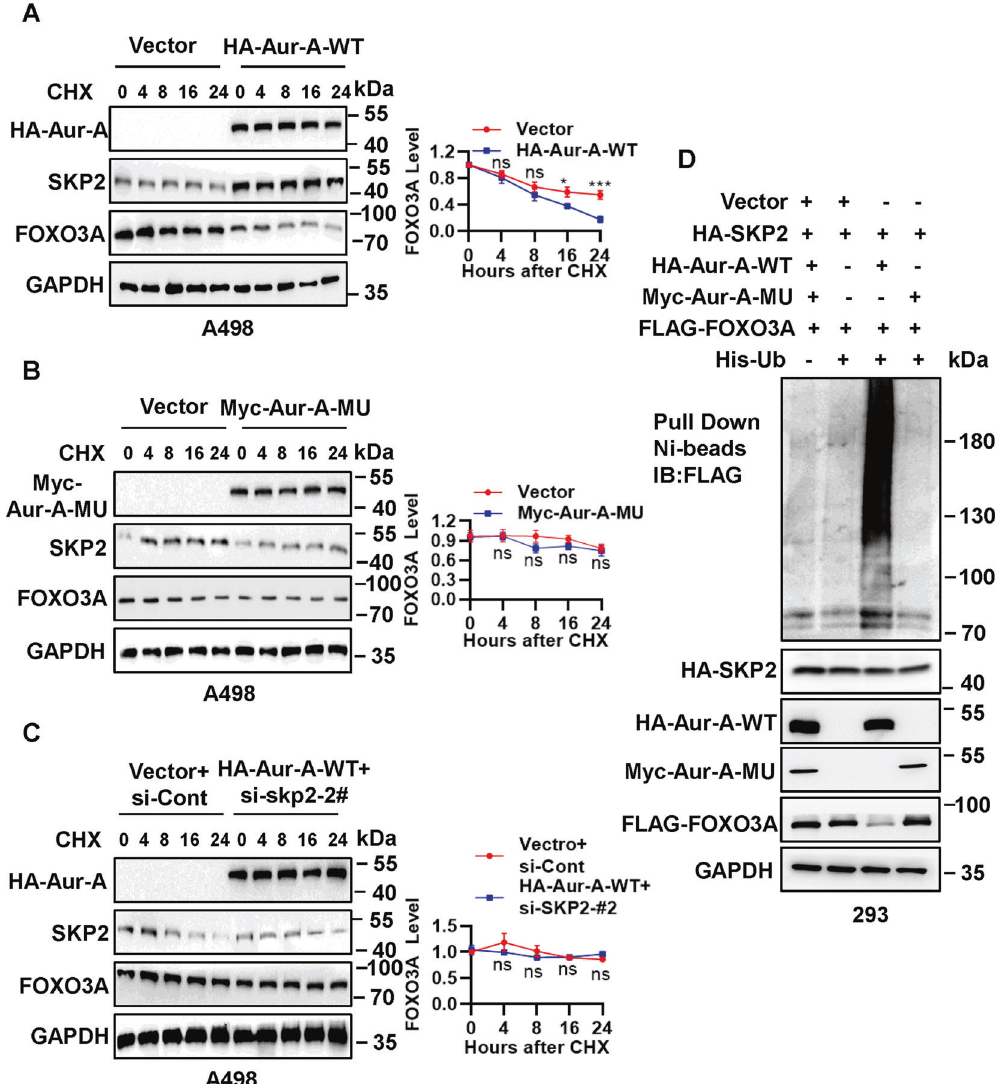
Fig. 5 FOXO3A ubiquitylation and degradation by SKP2 mediating depends on the kinase activity of Aur-A. A , B Overexpression of wild- type Aur-A signi fi cantly shortened the protein half-life of endogenous FOXO3A and enhanced SKP2 protein in ccRCC cells, but its mutant failed. After A498 cells were transfected with HA- Aur-A-WT ( A ) or myc-Aur-A-MU ( B ) for 48 h, cells were switched to fresh medium (10% FBS) containing cycloheximide (CHX) and incubated for indicated time periods before being harvested for IB. C Simultaneously transfected with Aur-A-WT and siRNA-SKP2, which had no effects on FOXO3A half-life. A498 cells were transfected with vector or HA-Aur-A-WT, along with transfection of siRNAs targeting SKP2 (siRNA-SKP2-2#), cells were switched to fresh medium (10% FBS) containing CHX and incubated for indicated time periods before being harvested for IB. D SKP2 promoted ubiquitylation of FOXO3A by dependent on kinase activity of Aur-A. 293 cells were transfected with indicated plasmids, lysed under denatured condition at 6 M guanidinium solution, followed by Ni-beads pull- down. Washed beads were boiled for IB to detect ubiquitylation of exogenous FOXO3A. The protein levels were normalized to GAPDH. ns no signi fi cance; * p < 0.05, *** p < 0.001; n = 3 independent experiments; two-tailed unpaired Student ’ s t trials to evaluate combined Aur-A and SKP2 inhibitors to enhance the anti-ccRCC effects observed with single-agent inhibitor alone. In conclusion, we reveal that overexpression of SKP2 enhances cell proliferation of ccRCC, while SKP2 depletion exhibits the opposite effect. SKP2 is positively correlated with Aur-A in ccRCC tissues and cells, and its protein and mRNA levels are elevated or reduced by Aur-A overexpression or silencing, respectively. It is further found that Aur-A also causes an increase phosphorylation of FOXO3A, which its ubiquitylation and degradation by SKP2 mediating depends on the kinase activity of Aur-A. Collectively, Aur-A/FOXO3A/SKP2 axis can promote ccRCC cell progression and the combination of Aur-A inhibitor MLN8237 and SKP2 inhibitor